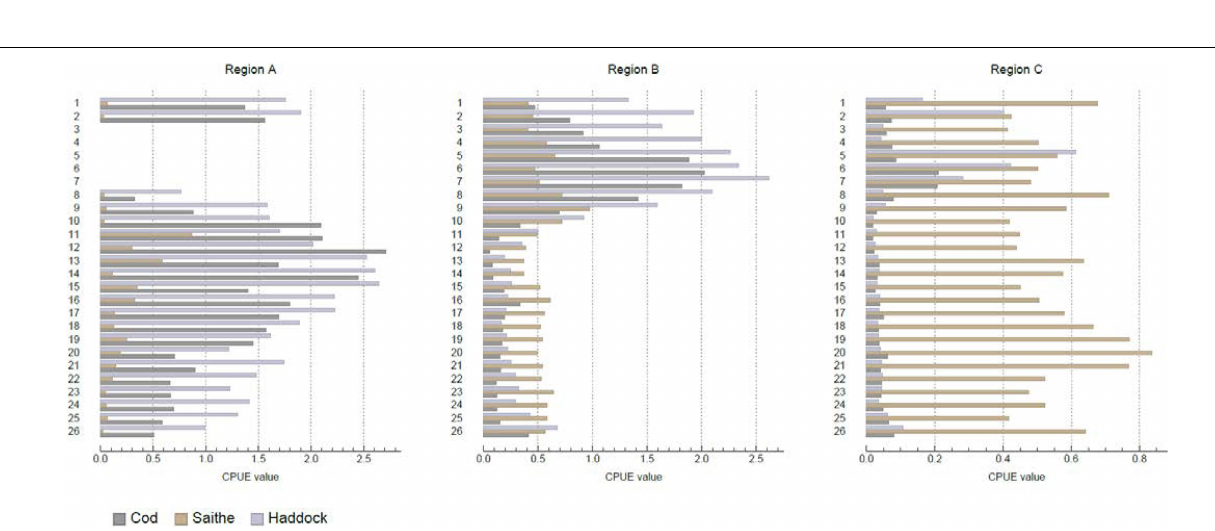
FIGURE 4 | Average of fortnightly variation in the catch per unit of effort (CPUE) of cod, saithe, and haddock fisheries in regions A, B, and C. CPUE is measured in tons of fish caught per hour of trawling for 53 trawl vessels. The Norwegian Directorate of Fisheries (Norwegian: Fiskeridirektoratet).